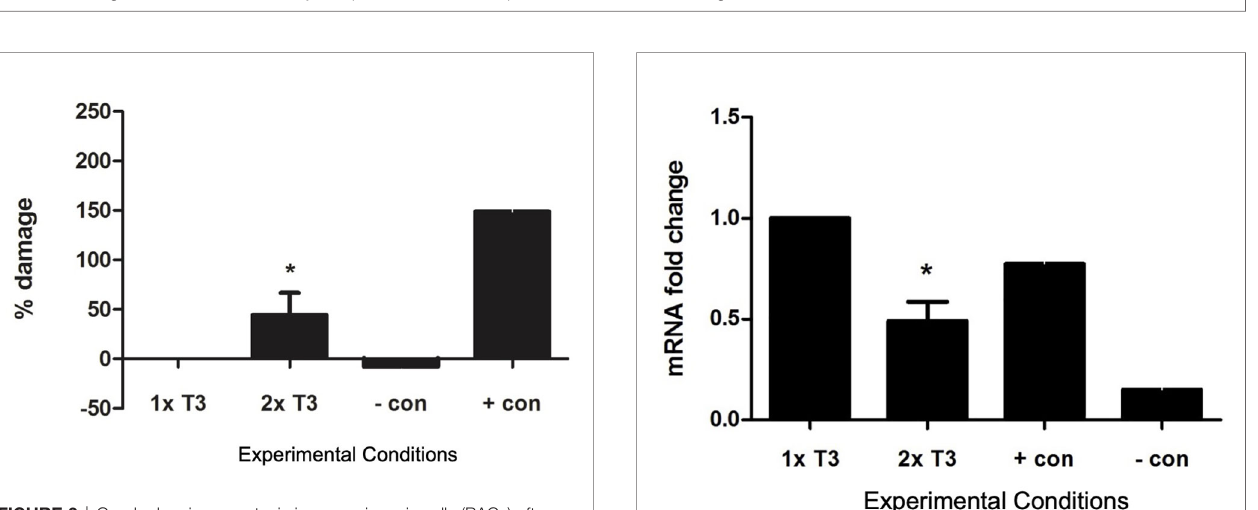
FIGURE 2 | RT-PCR for TR a 1 in PAC and HUVEC samples. All samples are shown positive for TR a 1 mRNA expression. RT − , without reverse transcriptase. The size of DNA fragments was determined by comparison with a 100-bp DNA ladder molecular weight marker.